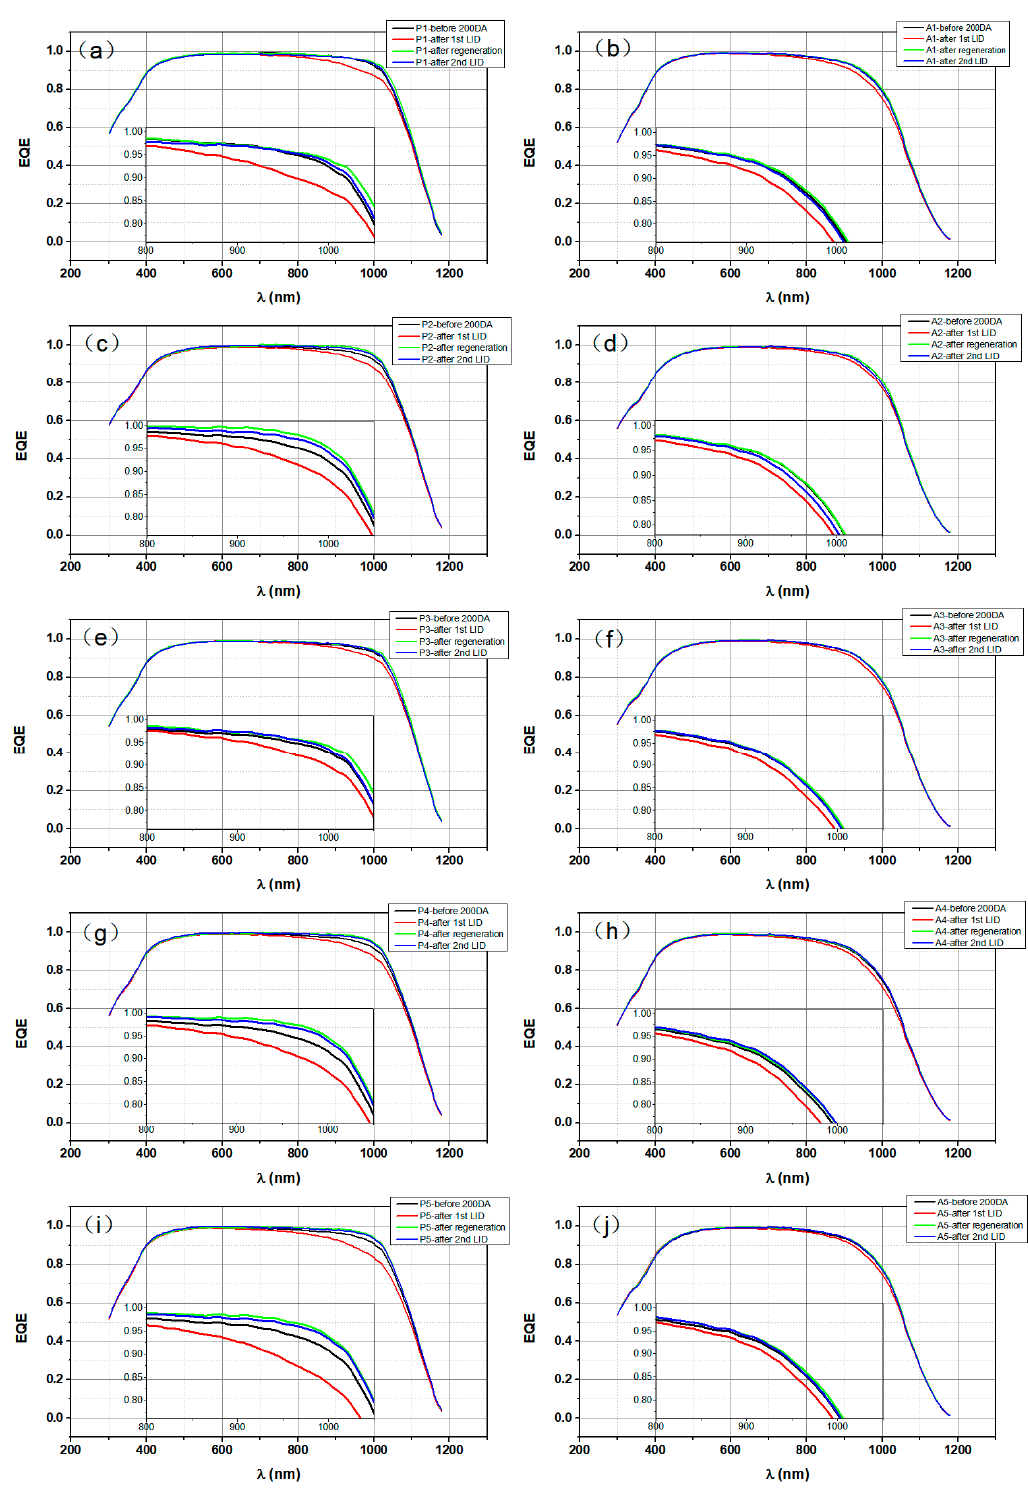
Figure 5. EQE curves of five groups of PERC ( left column) and Al-BSF cells ( right column) measured at four time-nodes of the experiment. (a) EQE of PERC cell P1; (b) EQE of Al-BSF cell A1; (c) EQE of PERC cell P2; (d) EQE of Al-BSF cell A2; (e) EQE of PERC cell P3; (f) EQE of Al-BSF cell A3; (g) EQE of PERC cell P4; (h) EQE of Al-BSF cell A4; (i) EQE of PERC cell P5; (j) EQE of Al-BSF cell A5. To sum up, the exponential decays of the four I - V characteristic parameters of both cells during the first LID were mainly caused by the generation of the degraded state